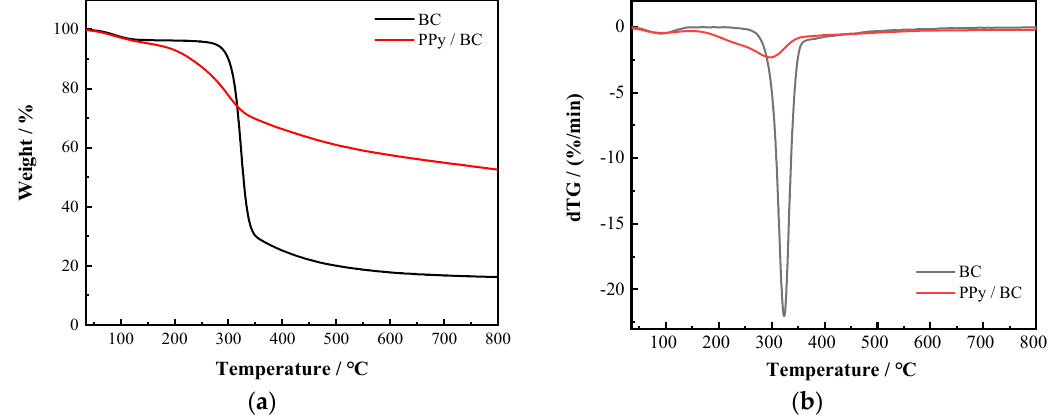
Figure 6. ( a ) Thermogravimetric analysis (TGA) and ( b ) derivative thermogravimetric (DTG) curves of pure BC and PPy/BC nanocomposite.